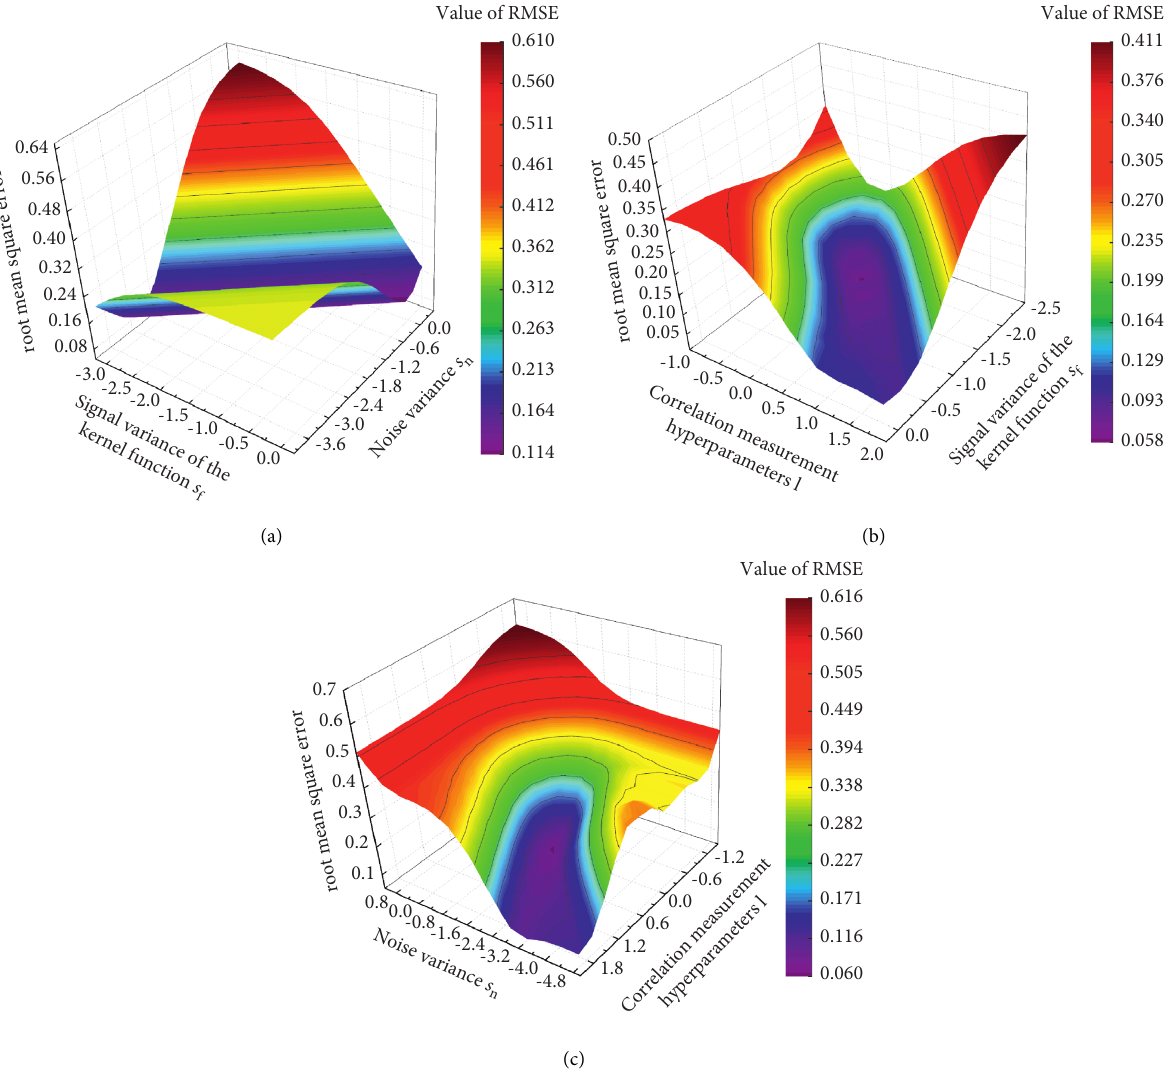
Figure 8: The influence of GP hyperparameters on regression accuracy. (a) The influence of σ influence of σ f and l on regression accuracy. (c) The influence of σ n and l on regression